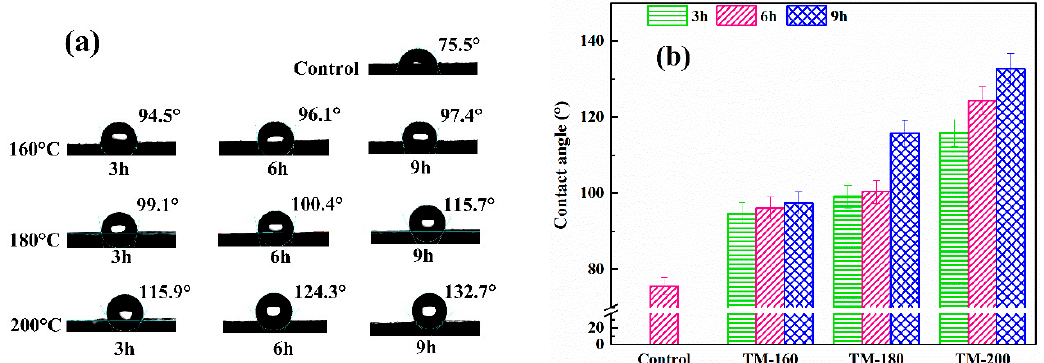
Figure 5. Contact angle in the tangential section of the control and thermally-modified woods.